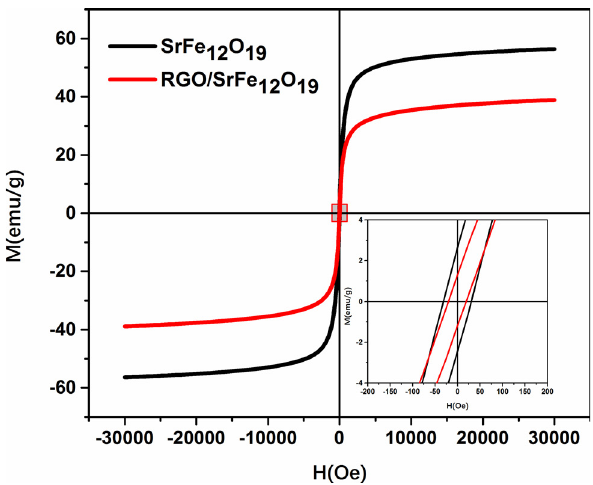
Figure 3: Magnetic hysteresis loops for SrFe 12 O 19 nanoparticles and RGO/SrFe O 12 19